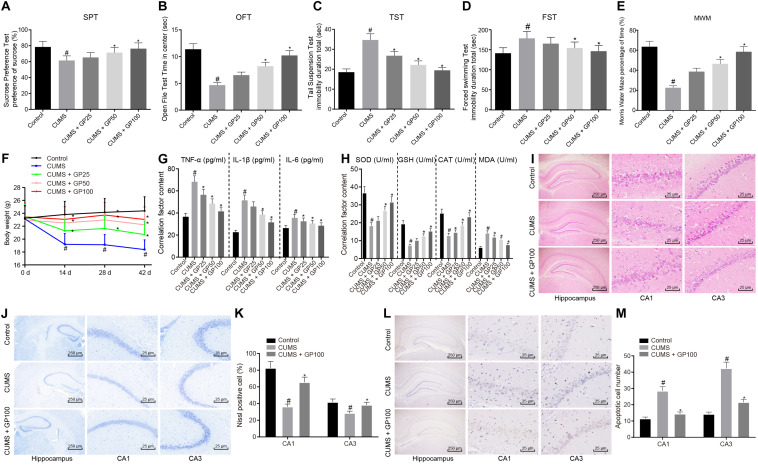
GP treatment relieves depression-like behavior and oxidative stress in CUMS-induced mice. The mice used for experiments were as follows: control mice, CUMS-induced mice and CUMS-induced mice administered with GP25, GP50, or GP100. (A) Sucrose preference of mice detected by SPT. (B) The retention time in open field of mice detected by OFT. (C) The immobility time of mice detected by TST. (D) The immobility time in water of mice detected by FST. (E) The percentage of time mice spent in the target quadrant of the platform detected by MWM. (F) the Weights of mice at the day 0, 14, 28, and 42 of CUMS induction. (G) The serum levels of TNF-α, IL-1β, and IL-6 in mice detected by ELISA. (H) The serum levels of SOD, MDA, GSH, and CAT in mice detected by ELISA. (I) The hippocampus tissues in mice observed by HE staining. (J,K) Representative views (J) and Nissl positive cell ratio (K) in hippocampus tissues of mice detected by Nissl staining. (L,M) Representative views (L) and apoptotic neuron ratio (M) in hippocampus tissues of mice detected by TUNEL staining. The measurement data were presented as mean ± standard deviation. Data comparison among multiple groups was analyzed by one-way ANOVA, followed by Tukey’s post hoc test. Data at different time points among multiple groups were compared by repeated measures ANOVA, and Bonferroni was applied for post hoc test. n = 15. *p < 0.05 vs. the CUMS-induced mice; #p < 0.05 vs. the control mice.